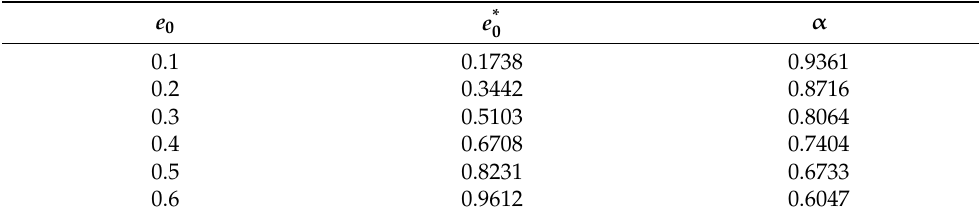
Table 1. Porosity coefficients for different distributions.